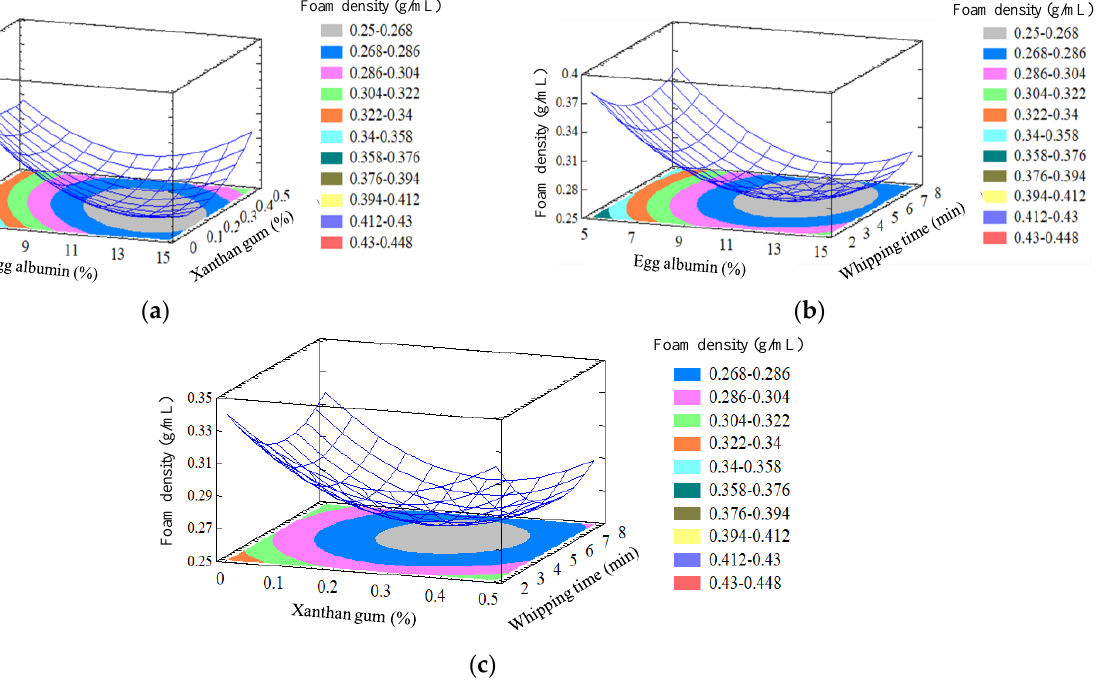
Figure 1. Response surface of foam density as a function of egg albumin, xanthan gum and whipping time. ( a ) whipping time 5 min; ( b ) xanthan gum 0.5%; and ( c ) egg albumin 10%.